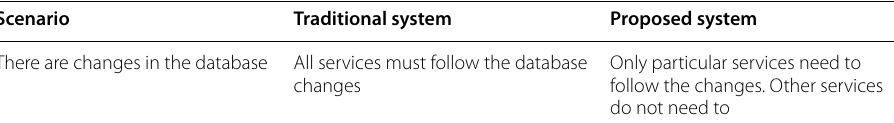
Table 7 System independence